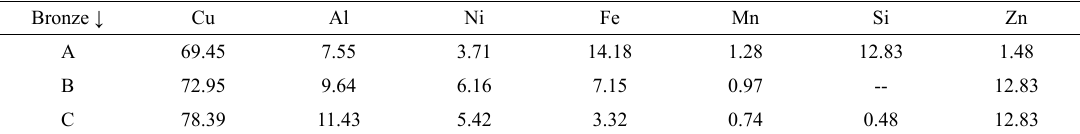
Table 1. Chemical composition (%wt.) of the as received commercial aluminum bronzes obtained by EDS.